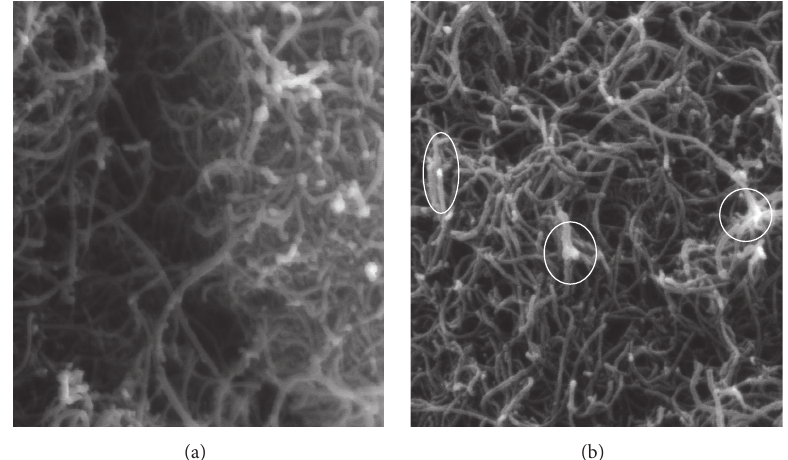
Figure 1: SEM images of (a) pure and (b) iron oxide impregnated CNTs conditions (voltage: 15 kV, resolution: 64 kX, and view field: 3 𝜇 m).